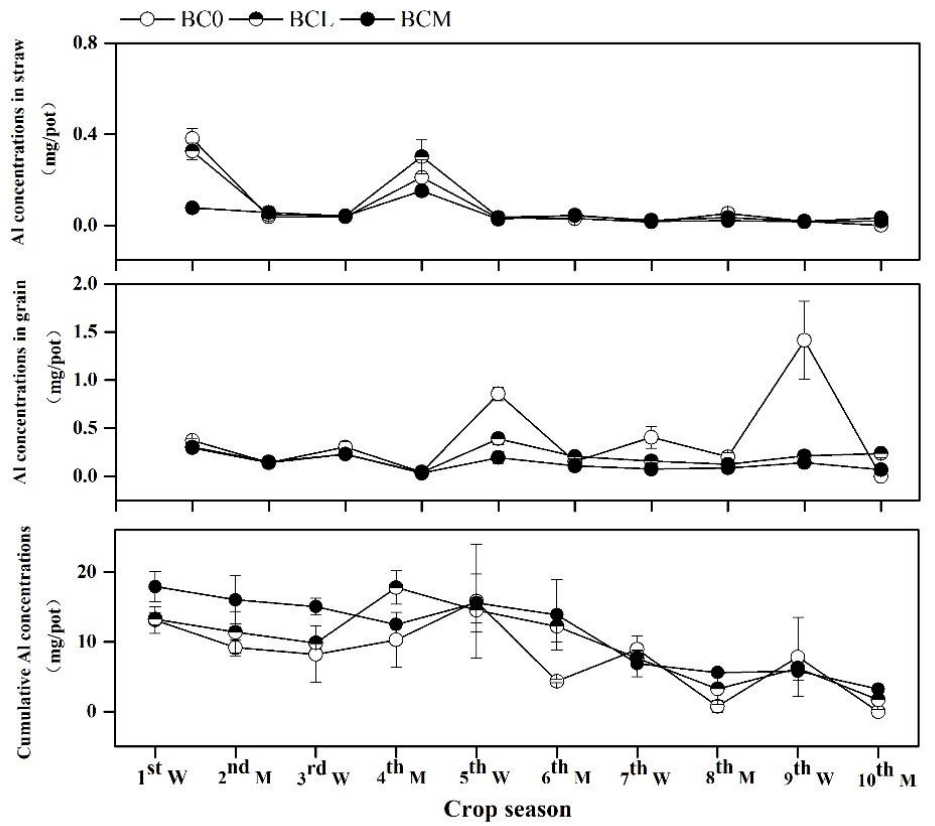
Figure 7. The change of concentration of Al in grain and straw and the uptake of Al by plant shoots in the red soil affected by successive application of straw biochar during 10 consecutive wheat/millet growing seasons from 2010 – 2015. Error bars are standard deviations. Table 3. The cumulative above-ground uptake of P, K, Ca, Na and Mg in red soil affected by suc- cessive applications of straw biochar during 10 consecutive wheat/millet growing seasons from 2010 – 2015.